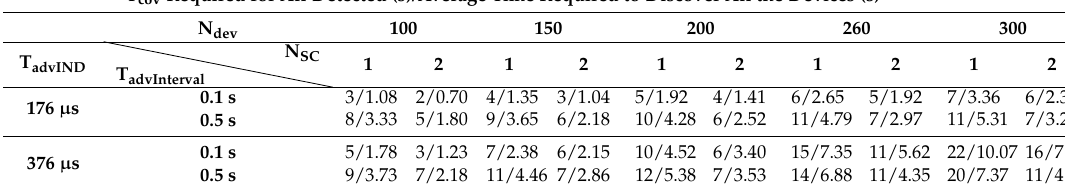
Table 3. Non-connectable undirected advertisement scheme . T cov required for detecting all the devices with 100% probability vs. average required to discover all the devices, for one (N sc = 1) and two (N sc = 2) scanners, for BLER =